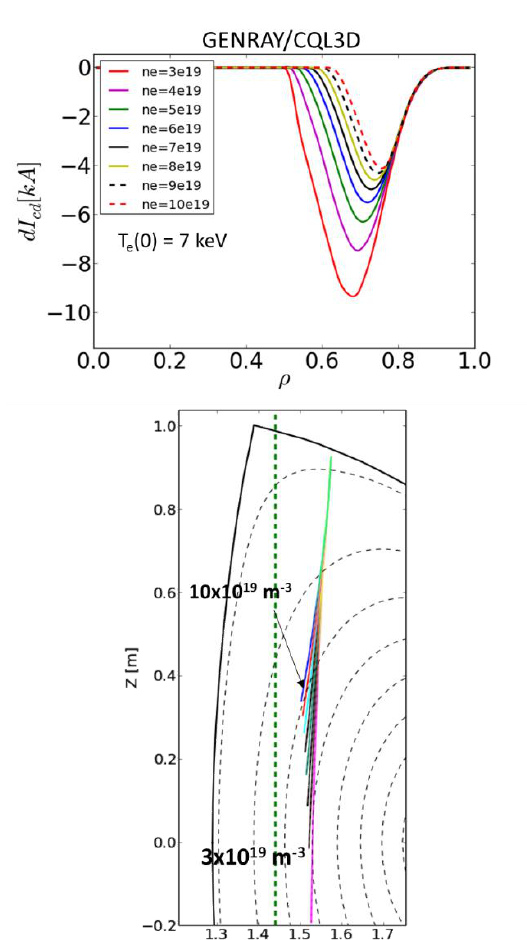
Fig. 6. The EC-driven current profiles and ray trajectories obtained GENRAY and CQL3D code as the plasma density increases. The vertical green dot line indicates the cold resonance line.